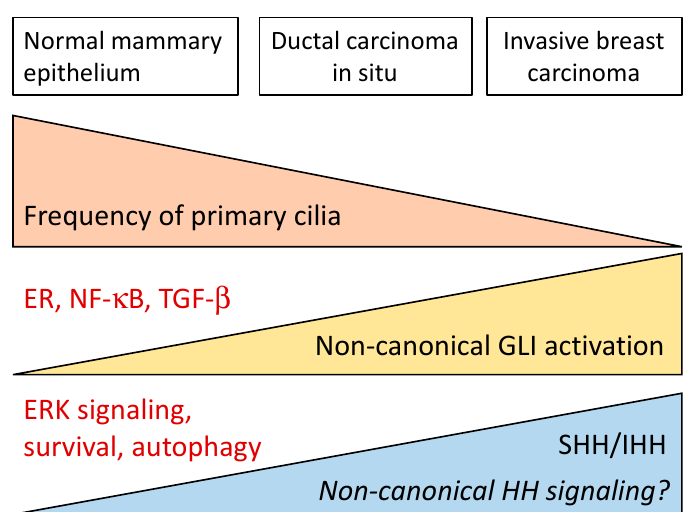
Figure 1. Proposed interpretation of the role of Hh signaling in BC from the combined pre-clinical and clinical data. As BC increases in grade and becomes more metastatic, the frequency of ciliated cells declines while GLI1 and Hh ligands expression increases. We postulate that the Hh ligands act by non-canonical signaling, increasing ERK signaling, inhibiting an apoptotic function of PTCH1 and promoting autophagy. GLI1 upregulation is presumably the result of crosstalk with other pathways (ER, NF-kB and TGF signaling).